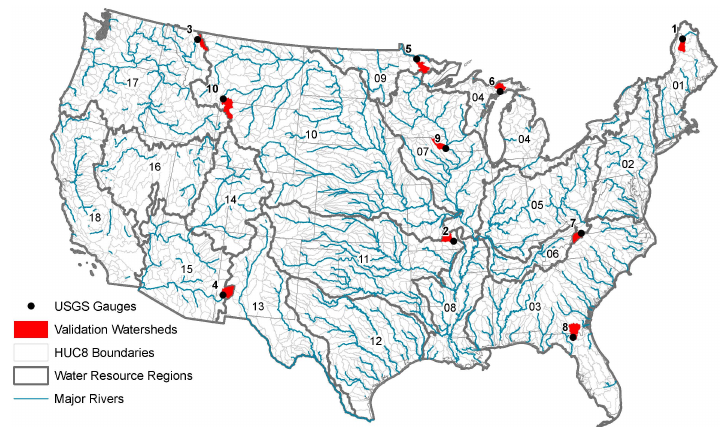
Fig. 2. Model validation watersheds, validation sites, Water Resource Regions, and 8-digit HUC (HUC8) boundaries of the conterminous US. Numbers 01 through 18 identify locations of Water Resource